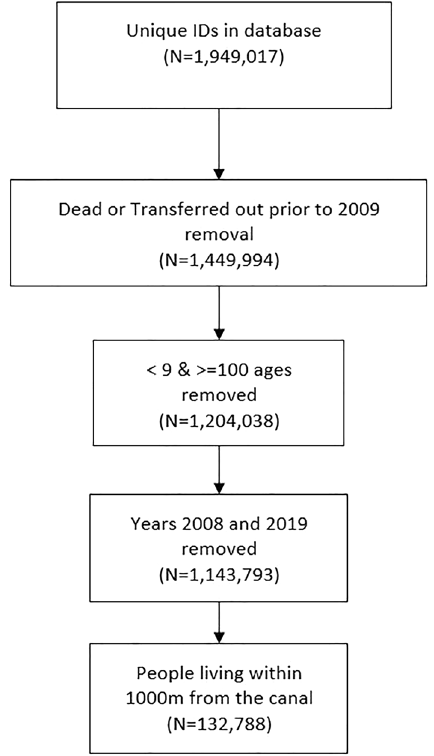
Figure 4. Data flow diagram.